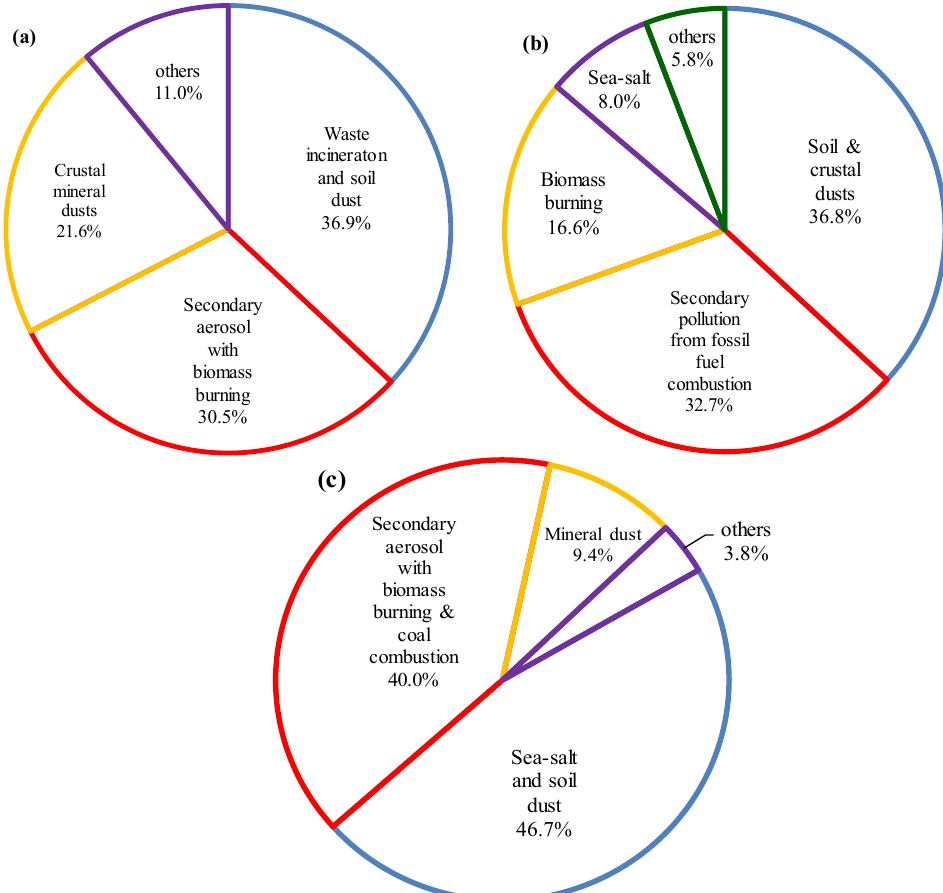
Figure 7. Source apportionments of water-soluble species in each episode: ( a ) haze, ( b ) mixed haze/Asian dust, and ( c ) Asian dust.